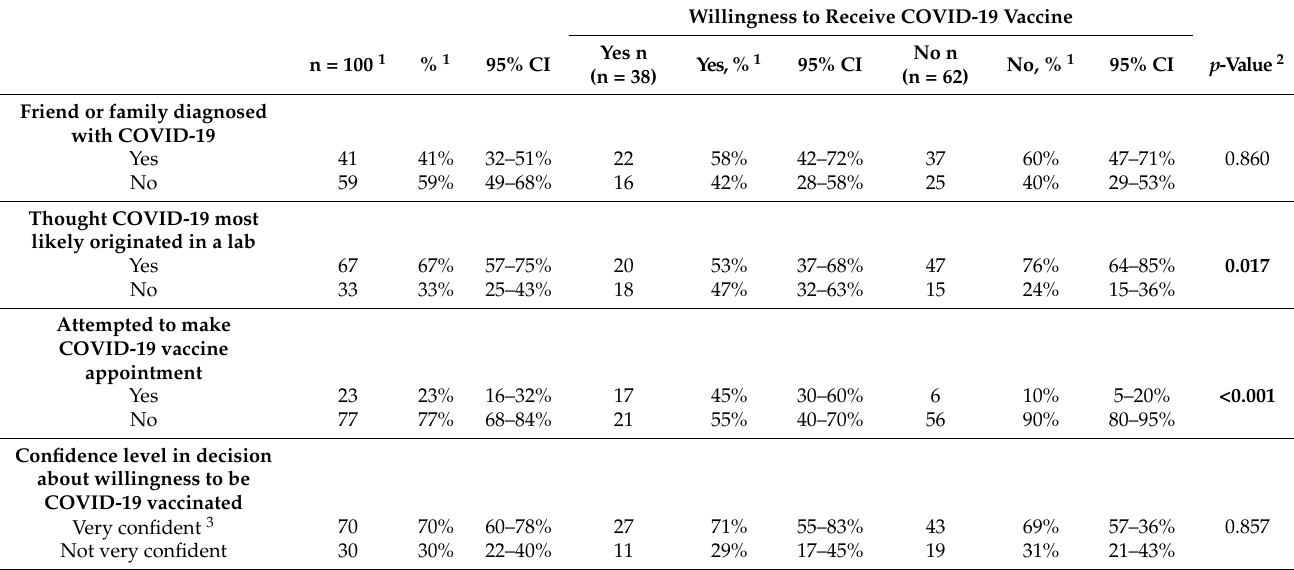
Table 2. Experiences and perceptions of vaccination, and associations with willingness to receive COVID-19 vaccine, among people who use drugs in NYC,